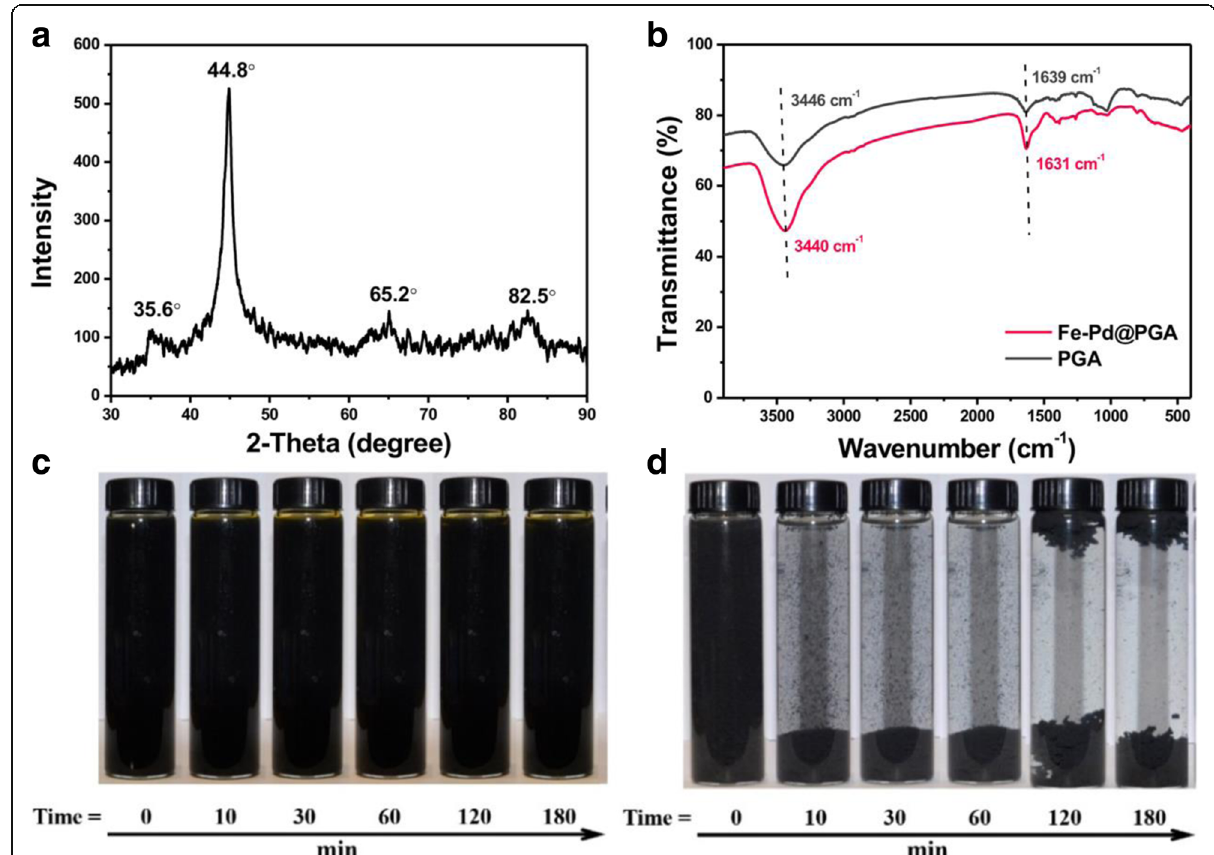
Fig. 2 a XRD pattern of Fe-Pd@PGA NPs. b FTIR spectra of PGA and Fe-Pd@PGA NPs. c , d Photos of Fe-Pd@PGA NPs ( c ) and bare Fe-Pd NPs ( d ) suspension at different